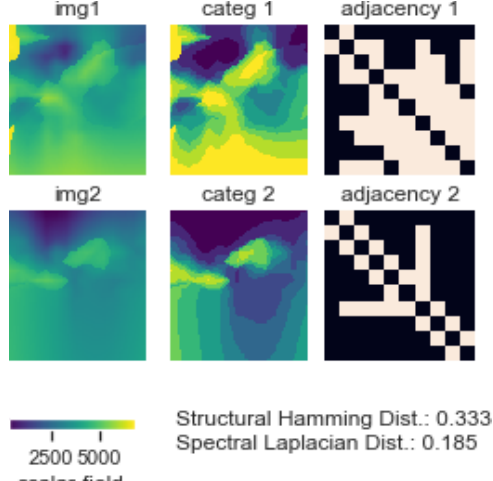
Figure 13. Illustration of topological distances and adjacency ma- trices in the right column for two categorised voxets in the middle column, derived from two scalar field voxet horizontal sections in the left